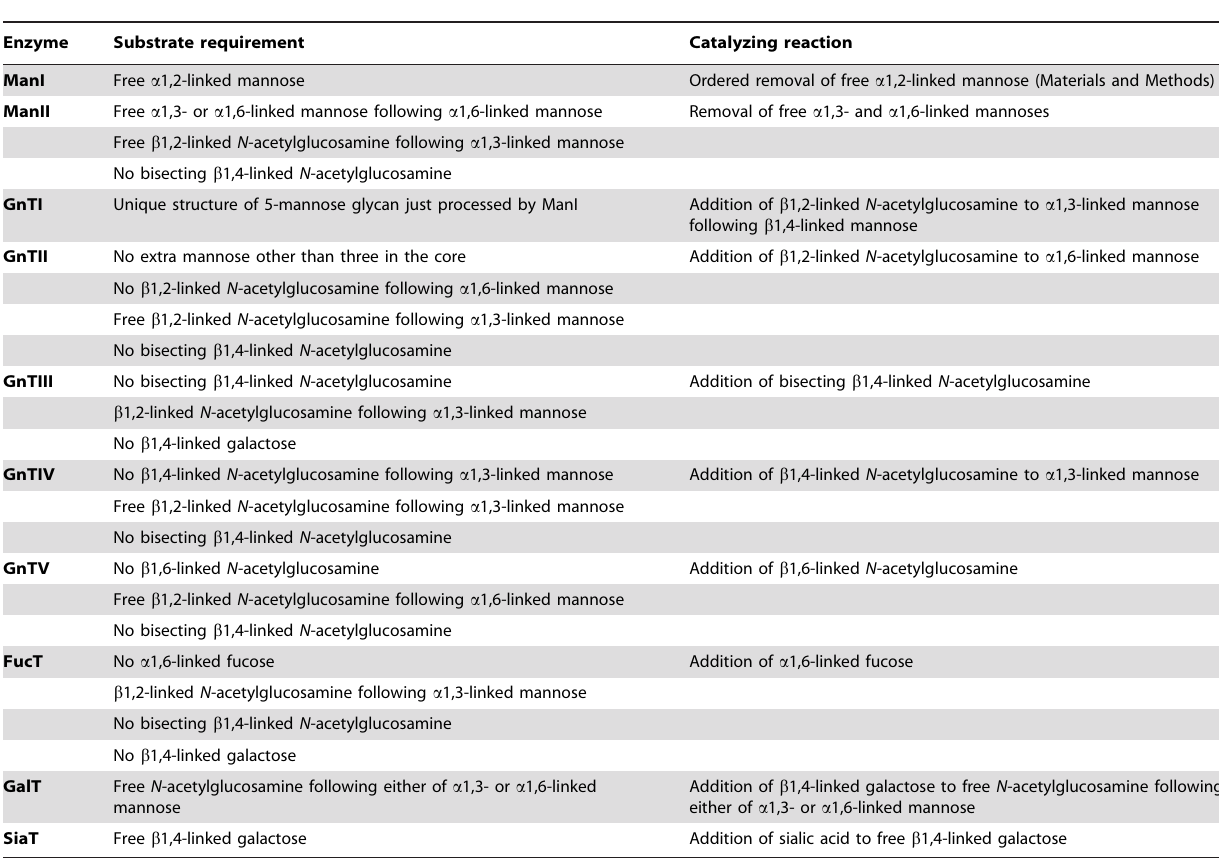
Table 1. Characteristics of enzymes used in network